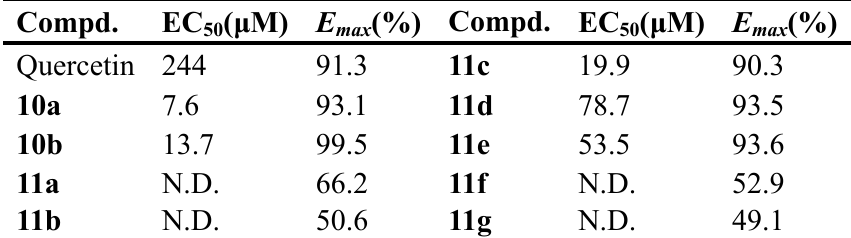
Table 1. The vasorelaxant activities of flavonoids 10a , b and 11a-g , in rat aorta rings pre-contracted with